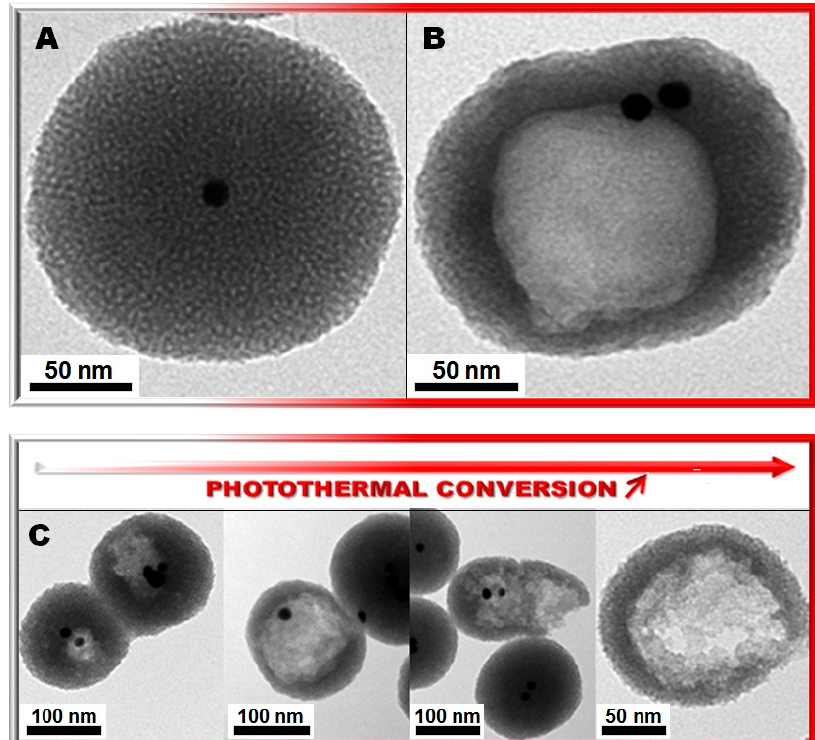
Figure 2. TEM images of Au@MSN before irradiation ( A ), and after 7 h of irradiation through an argon ion laser at 514 nm under 50 mW ( B ). Impact of the PT conversion of the gold cores on the MSN matrix under 50 mW ( C ).